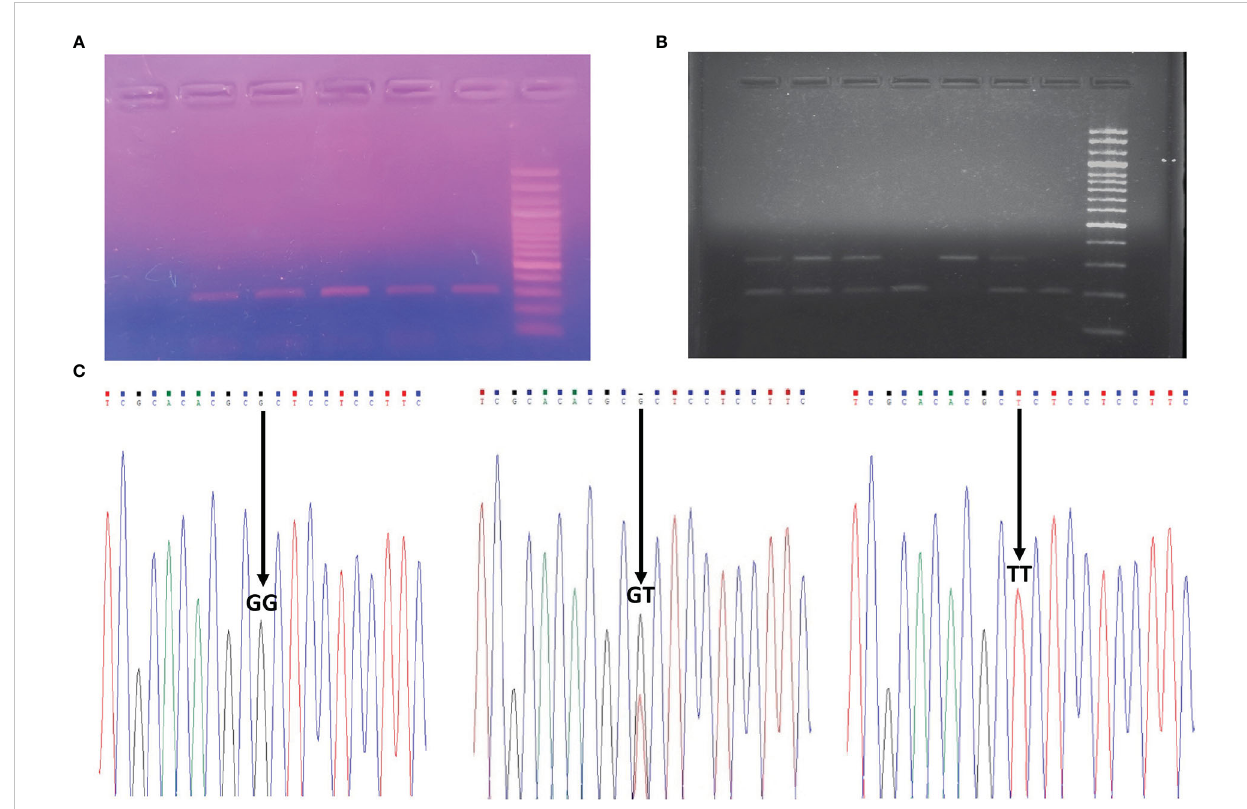
FIGURE 1 TBXA2R rs34377097 polymorphism. (A) PCR Product (311 bp). The last lane shows the 100 bp ladder. (B) RFLP fragments. GG genotype in Lane 4 and 7; GT genotype in Lane 1, 2, 3 and 6; TT genotype in Lane 5 (C) Representative chromatograms of GG, GT and TT genotype. The position of the genotypes is shown with an arrow.